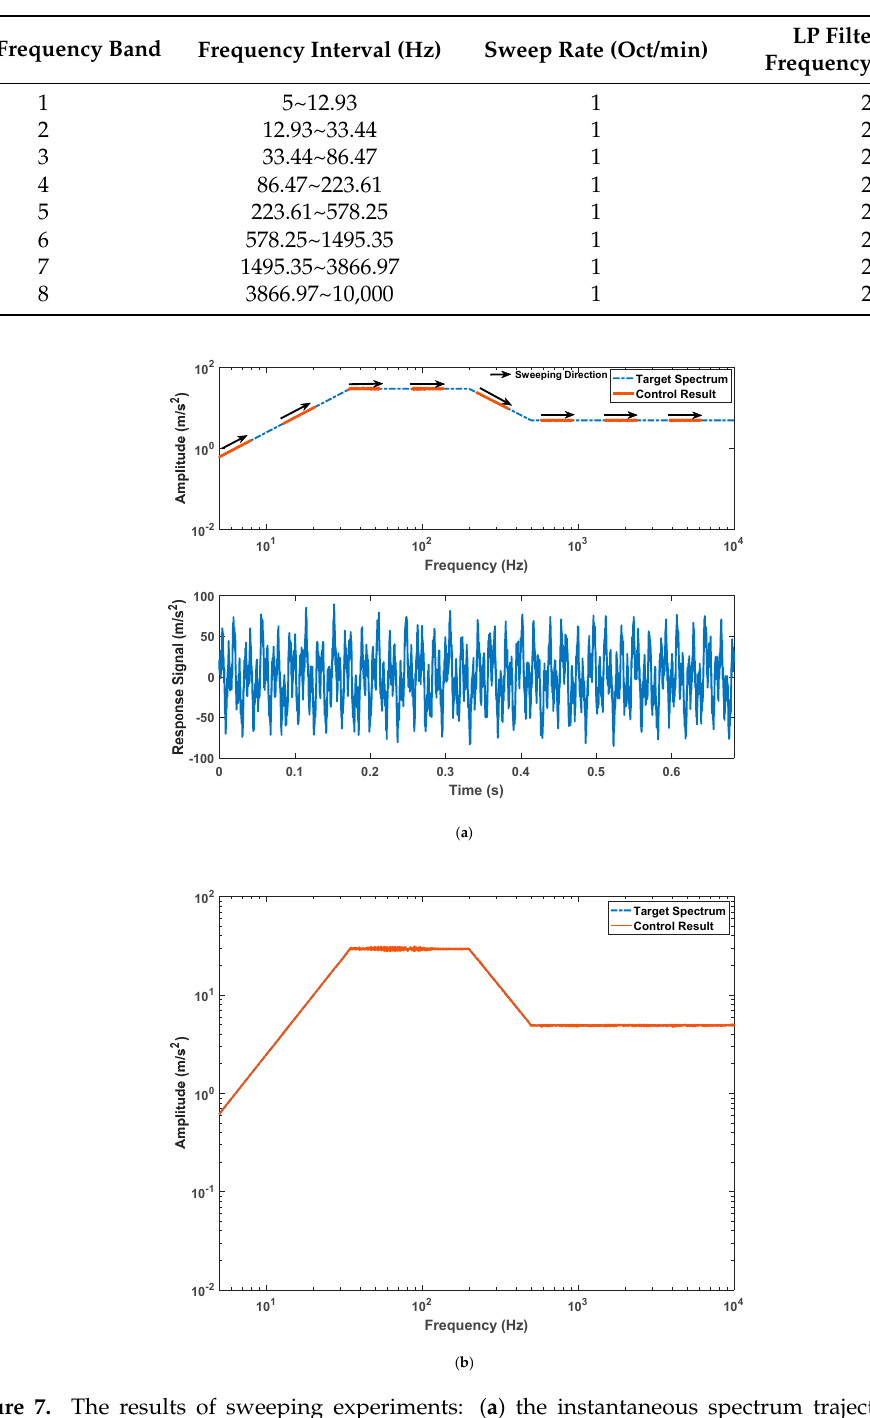
Table 2. The 8 sub-frequency band settings in sweeping experiment.